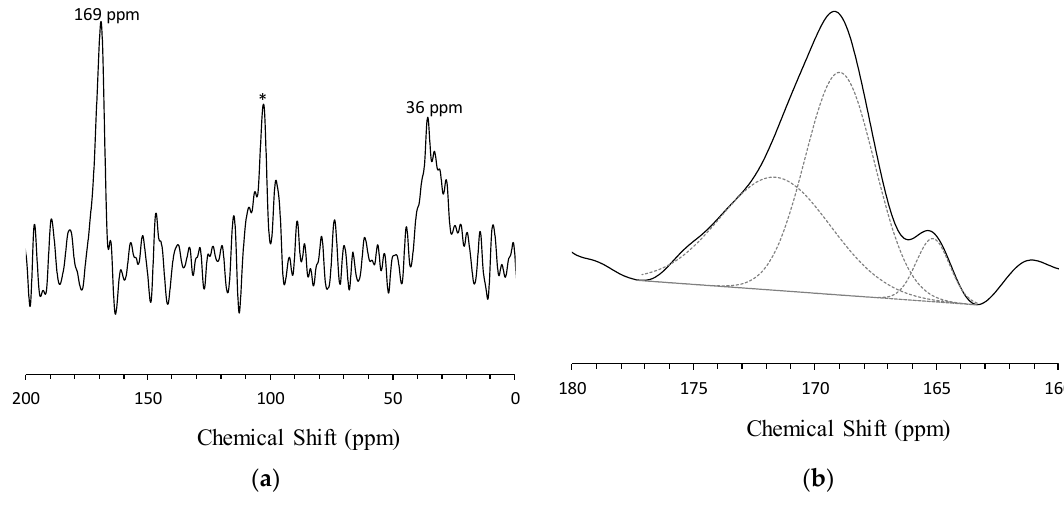
Figure 4. 13 C MAS NMR spectrum of carbonated alkali-activated fly ash. Spectral range of ( a ) 200 ppm to 0 ppm and; ( b ) 180 ppm to 160 ppm. The spinning sideband is marked with an asterisk.